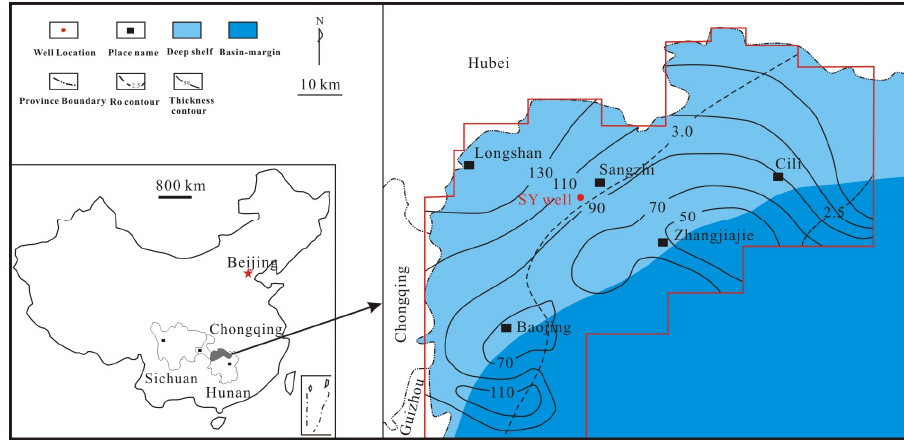
Figure 1. Location of the study area in northwestern Hunan Province, China.